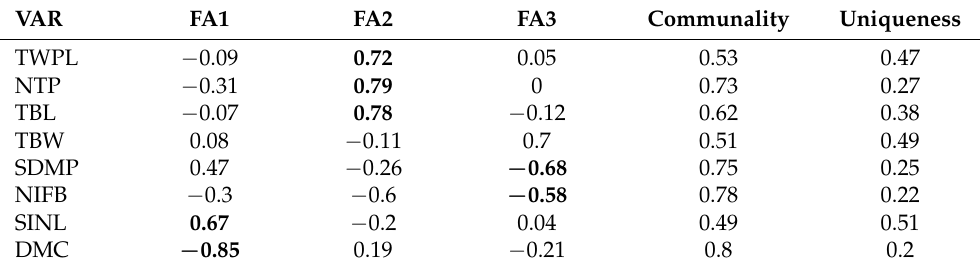
Table 5. Factorial loadings, communalities, and uniqueness of twenty-four selected genotypes based on the multi-trait genotype–ideotype index (MGDI) . (Bold values represent traits with high contribution to each